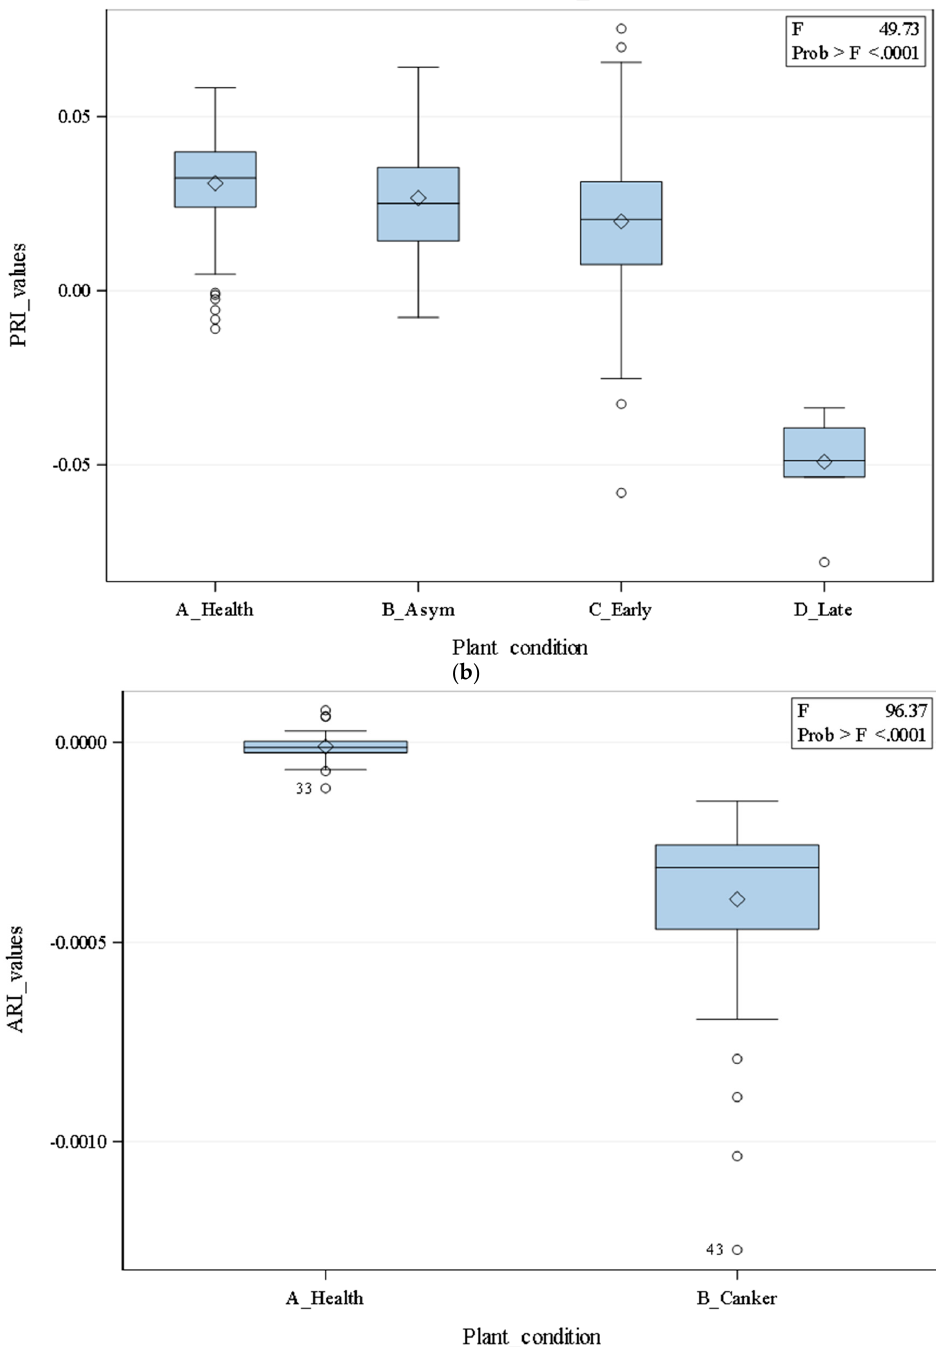
Figure 11. Comparison of the VI values in different plant conditions (healthy, asymptomatic stage, and early and late disease developmental stage) for citrus canker detection in both indoor and outdoor conditions. Most significant vegetation index values (for citrus canker disease detection) and their standard deviation in different plant conditions of ( a ) Water Index (WI) in laboratory conditions, ( b ) Photochemical Reflectance Index (PRI) in laboratory conditions, and ( c ) Anthocyanin Reflectance Index (ARI) in field conditions (UAV-based) are shown.